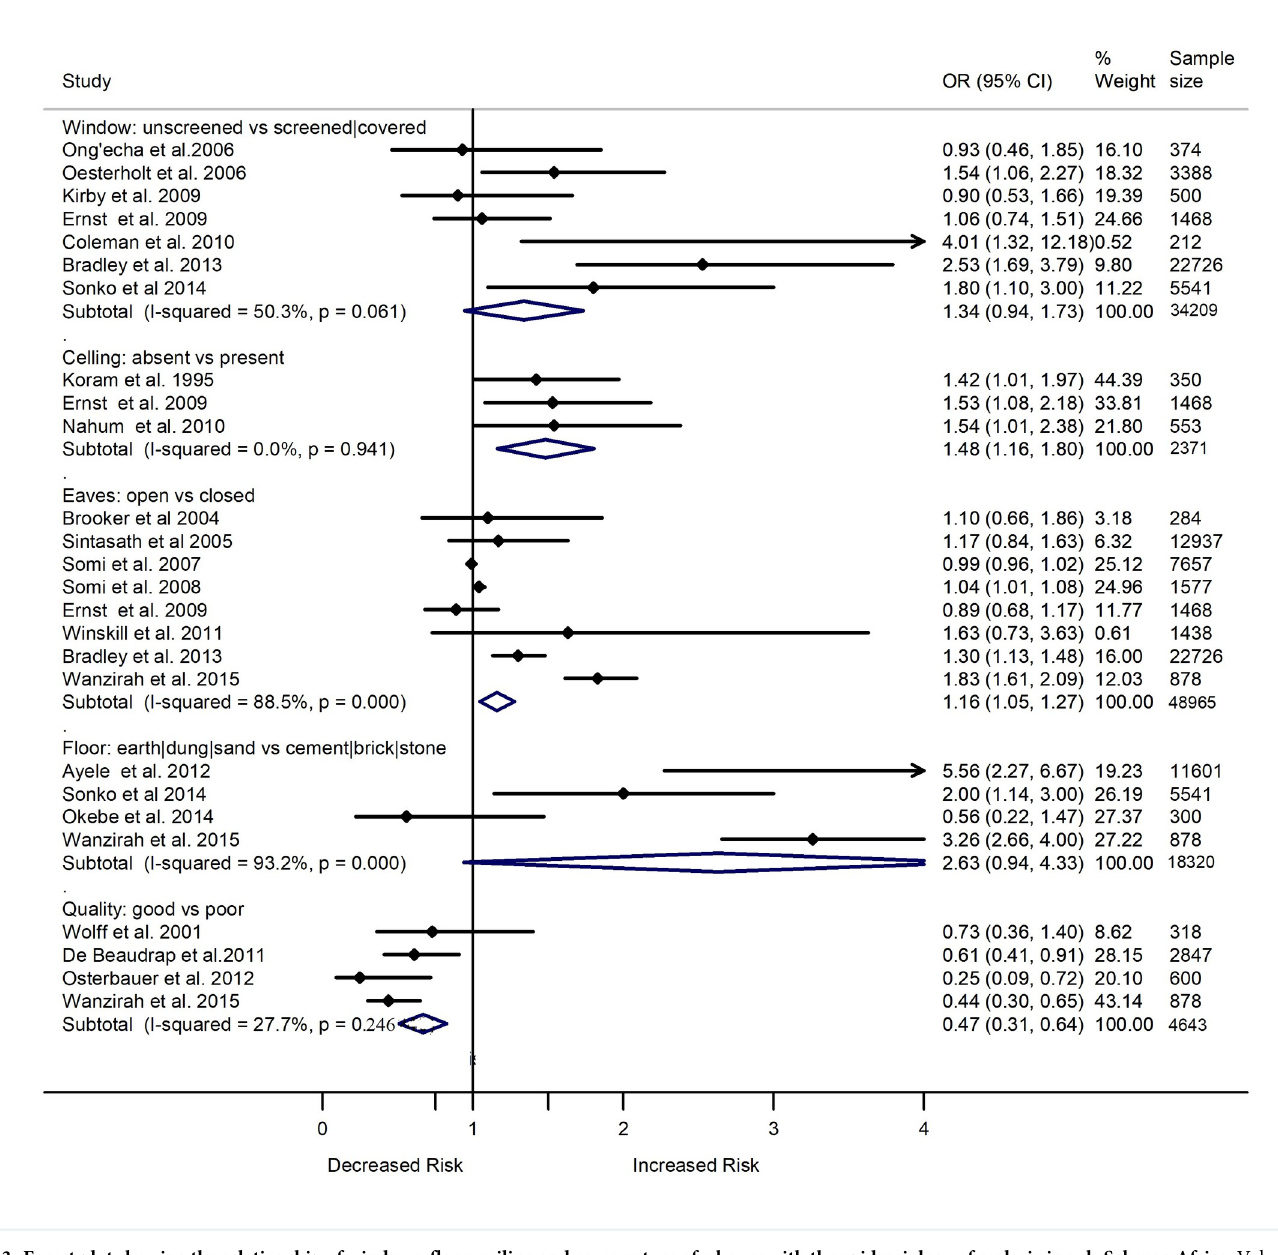
Fig 3. Forest plot showing the relationship of windows, floor, ceiling and eaves nature of a house with the epidemiology of malaria in sub-Saharan Africa. Values show the odds ratio of Plasmodium infection (95% CI). Subtotal (summary) ORs estimated using random effect models when I 2 � 30 and using fixed effect models when I 2 < 30. Weights estimated using inverse variance method. I 2 , a measure of